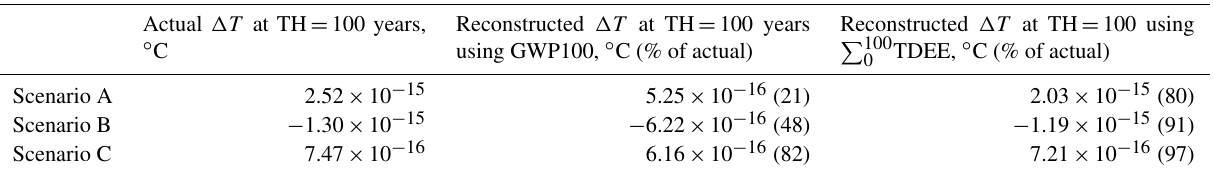
Table 5. Comparison of future (cid:49)T (global mean) from the RF (cid:49)α (t) scenarios shown in Fig. 7a reconstructed using GWP100 and (cid:80) 100 0